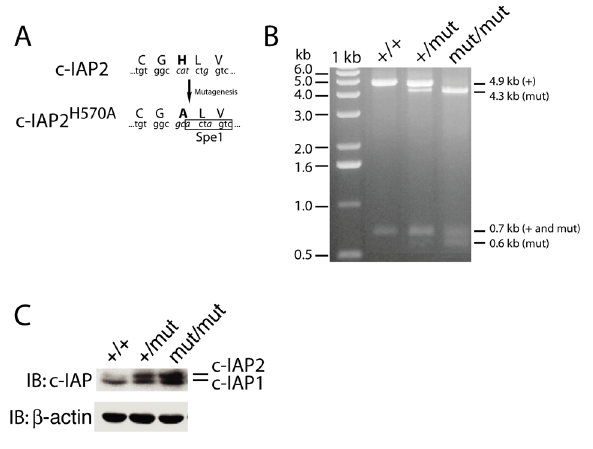
Figure 2. Generation of c-IAP2 H570A/H570A mice. (A) Site-directed mutagenesis of the Zn 2 + -coordinating histidine residue in the RING domain of c-IAP2. Lower and upper case letters denote the nucleotide and corresponding amino acid sequence, respectively, before and after mutagenesis. The bolded amino acids highlight the histidine to alanine replacement, and the italicized nucleotides highlight the nucleotide substitutions. The box depicts the novel Spe1 restriction endonuclease site. (B) Spe1 endonuclease digestion of PCR products amplified from wild type ( + / + ), c-IAP2 + /H570A ( + /mut), and c-IAP2 H570A/H570A (mut/mut) tail DNA. SpeI digestion of the PCR fragment amplified from the wild type ( + ) allele generates 4.9 and 0.7 kb fragments and the c-IAP2 H570A (mut) allele 4.3, 0.7, and 0.6 kb fragments. (C) c-IAP expression in + / + , + /mut, and mut/mut splenocytes was determined by immunoblot using an antiserum that recognizes both c-IAP1 and c-IAP2. b -actin expression was used as a loading control.